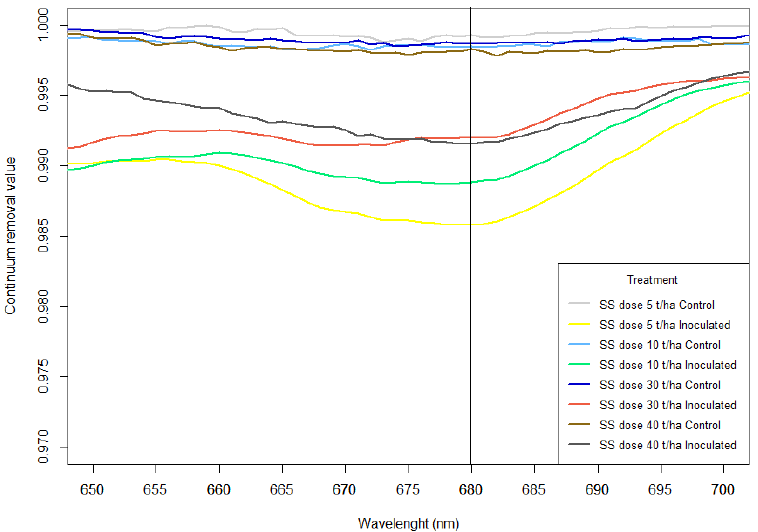
Figure 1. Continuum removal curves between 650 and 700 nm obtained for the control and inoculated samples for the different sewage sludge doses tested in the experiment, after 4